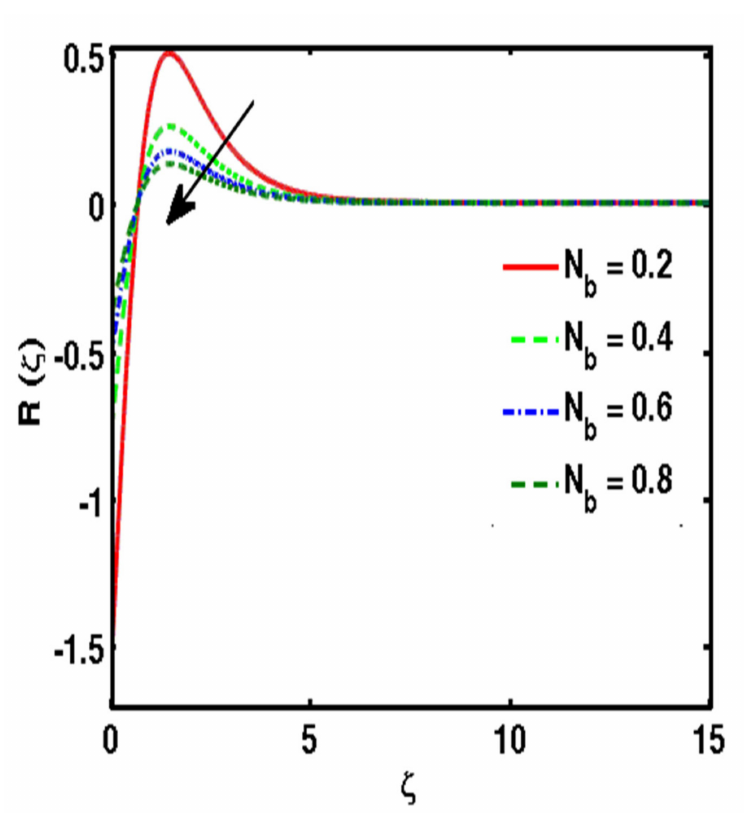
Figure 13. Variation of N t and φ ( ζ ) .